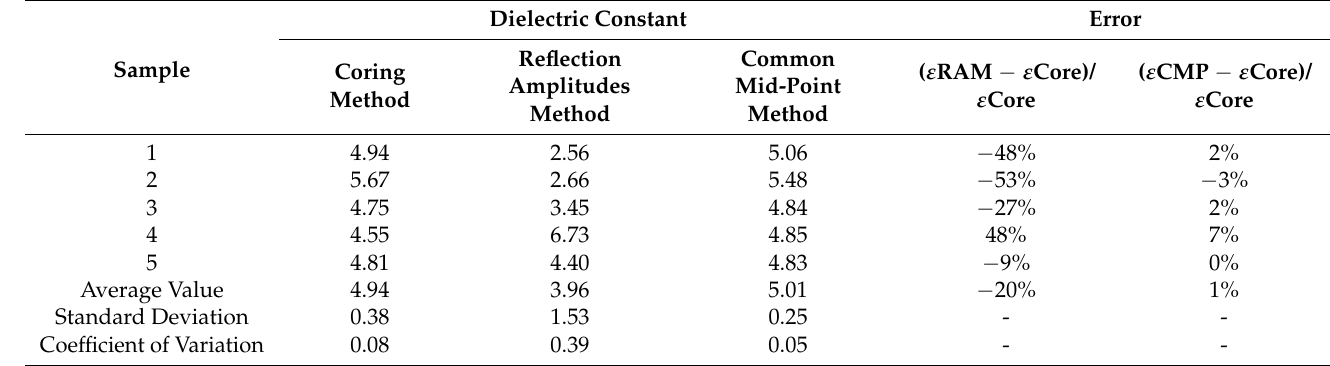
Table 3. Dielectric constants of asphalt concrete calculated by three calculation methods.